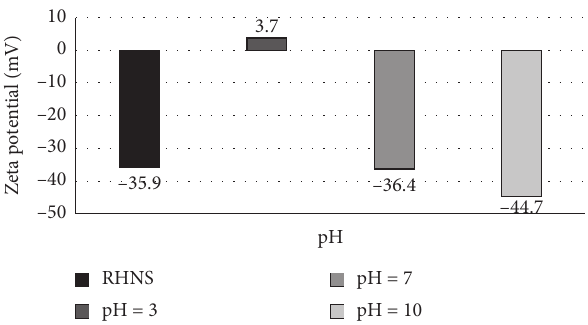
Figure 4: Zeta potential of RHNS with respect to pH.